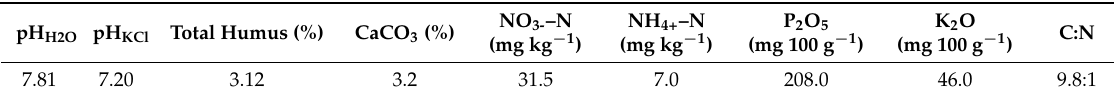
Table 6. Agrochemical properties of the soil sample from the experimental